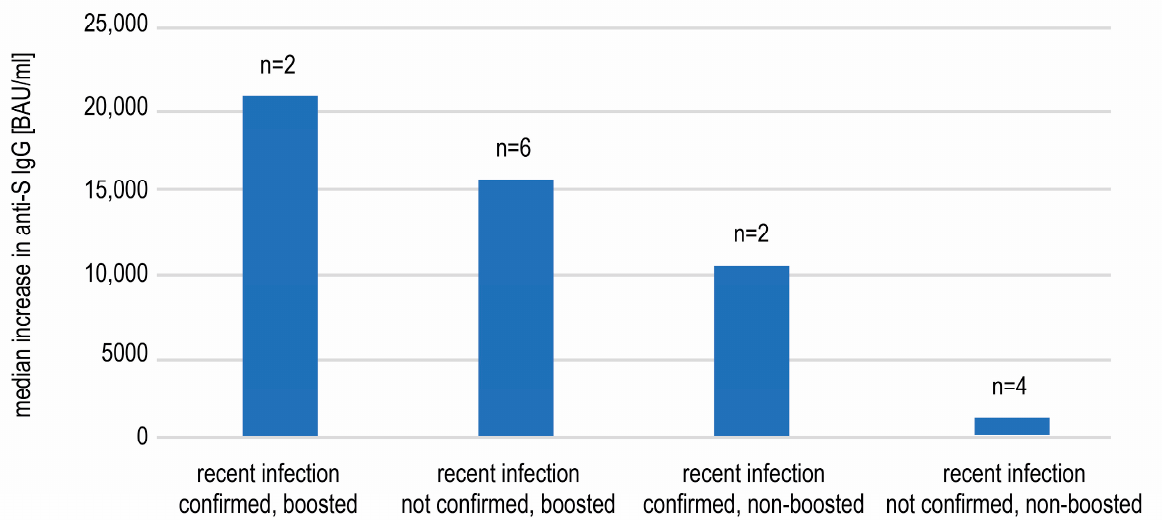
Figure 5. The median increases in the anti-spike SARS-CoV-2 IgG concentrations between days 240 and 360 observed in subgroups of recently infected individuals. The individuals with infection confirmed with a swab tended to display more pronounced rises in antibody